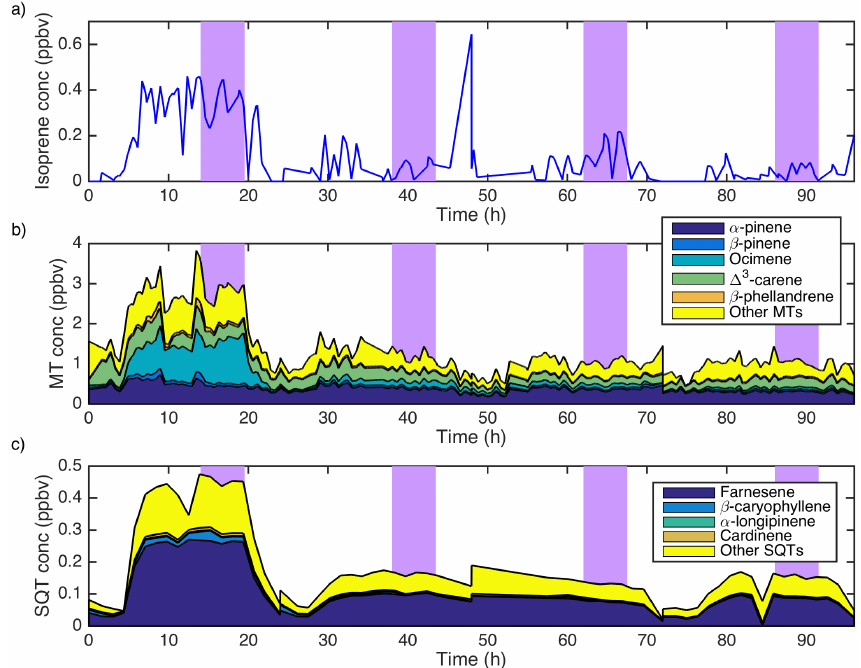
Figure 3. Isoprene (a) , monoterpene (b) , and sesquiterpene (c) concentrations measured from the outlet air of the JPAC plant chamber. In (b) and (c) we left out those terpenes that had a negligible contribution to the total terpene concentration. Purple bars indicate UV on periods during the